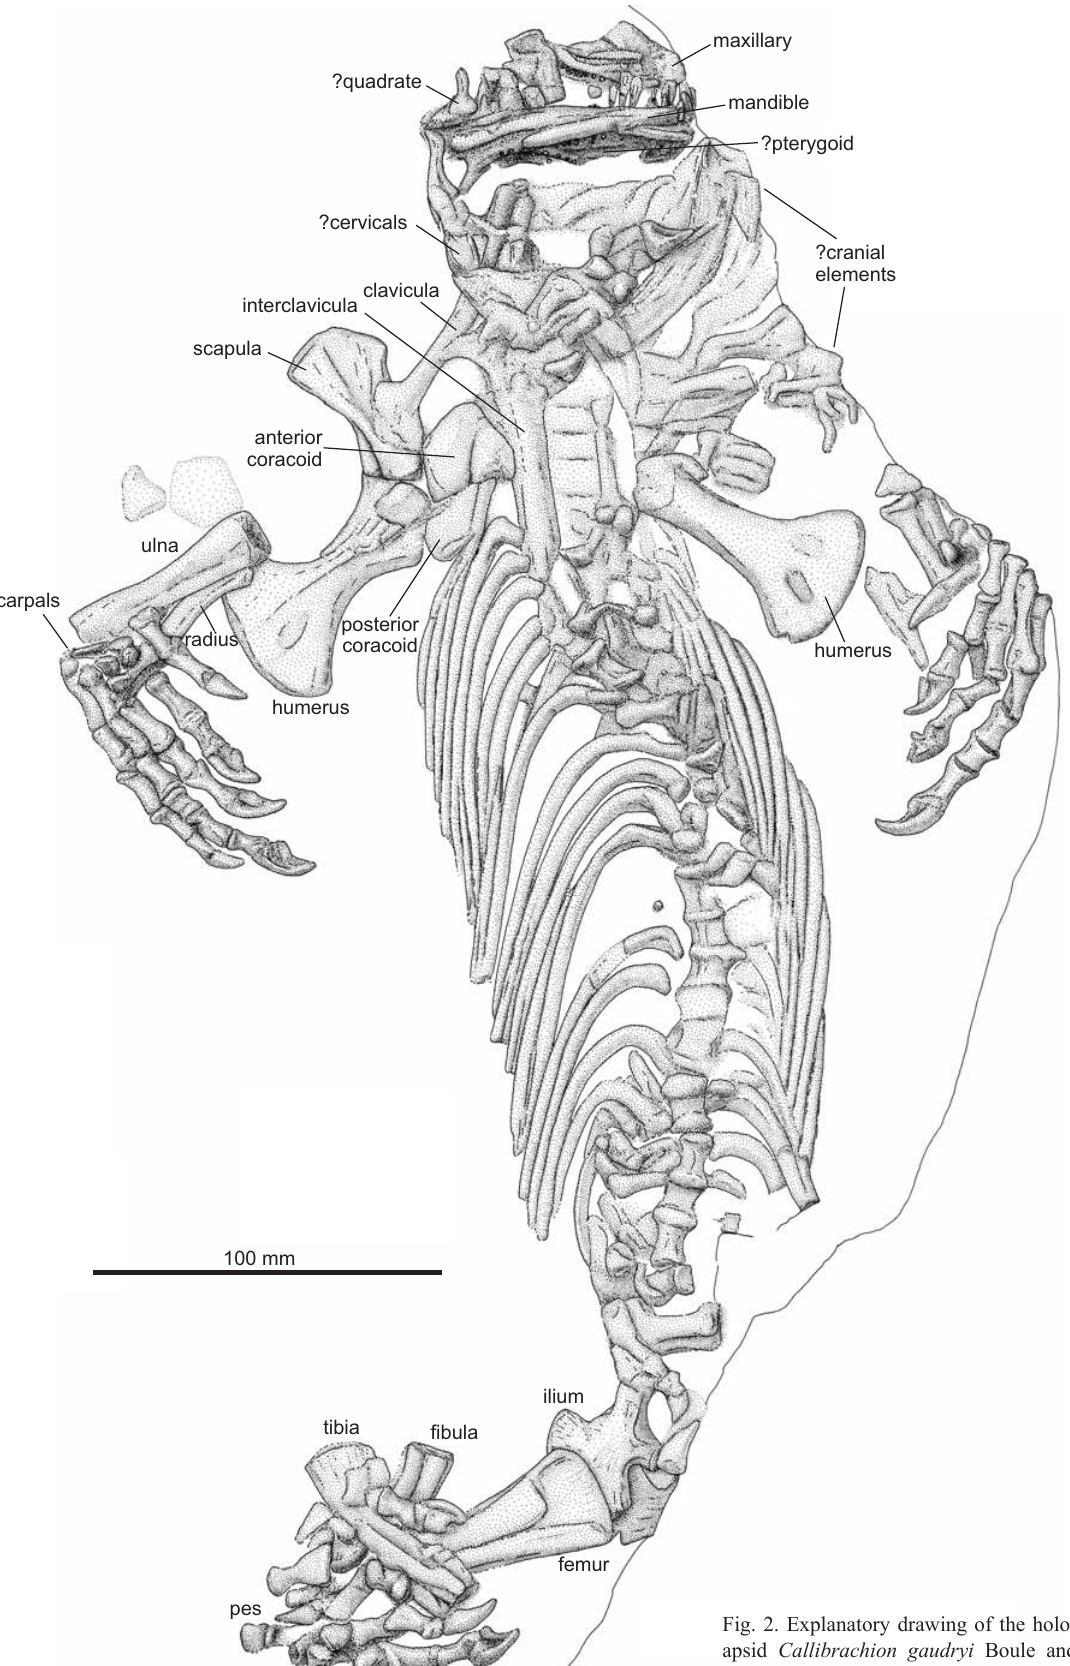
Fig. 2. Explanatory drawing of the holotype of caseasaurian syn- apsid Callibrachion gaudryi Boule and Glangeaud, 1893 from Cisuralian of Autun, France